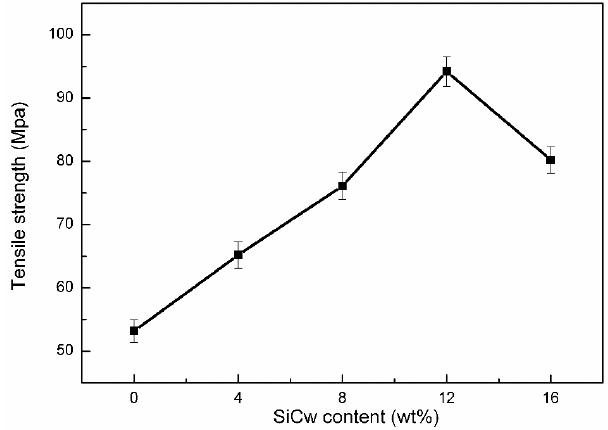
Figure 3. Tensile strength of the SiCw/hydro-epoxy composites.